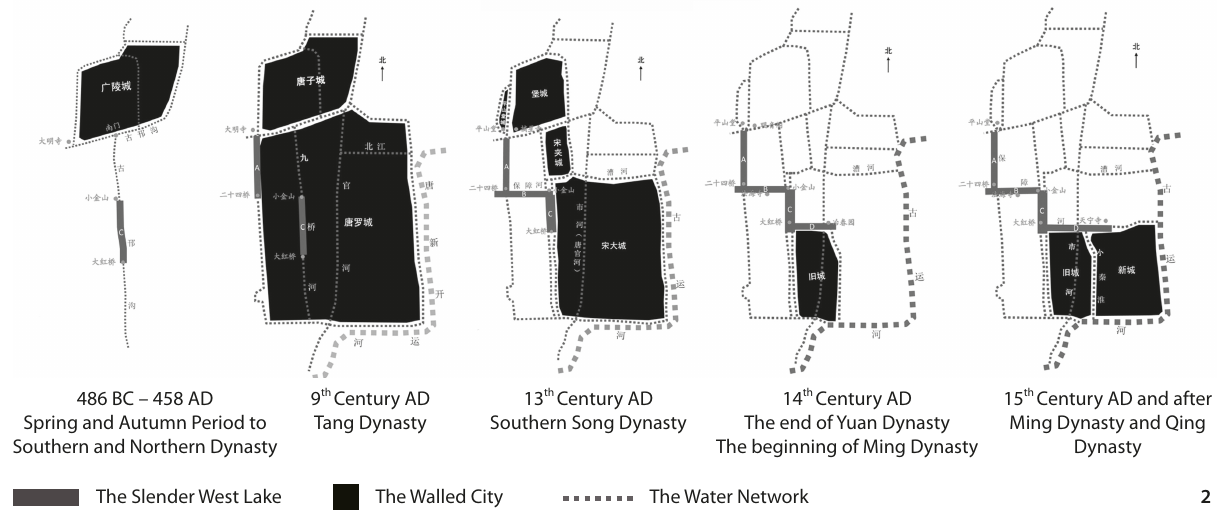
Figure 2 The re-mapping of the history of the Slender West Lake intertwined with the city of Yangzhou (Source: the author).